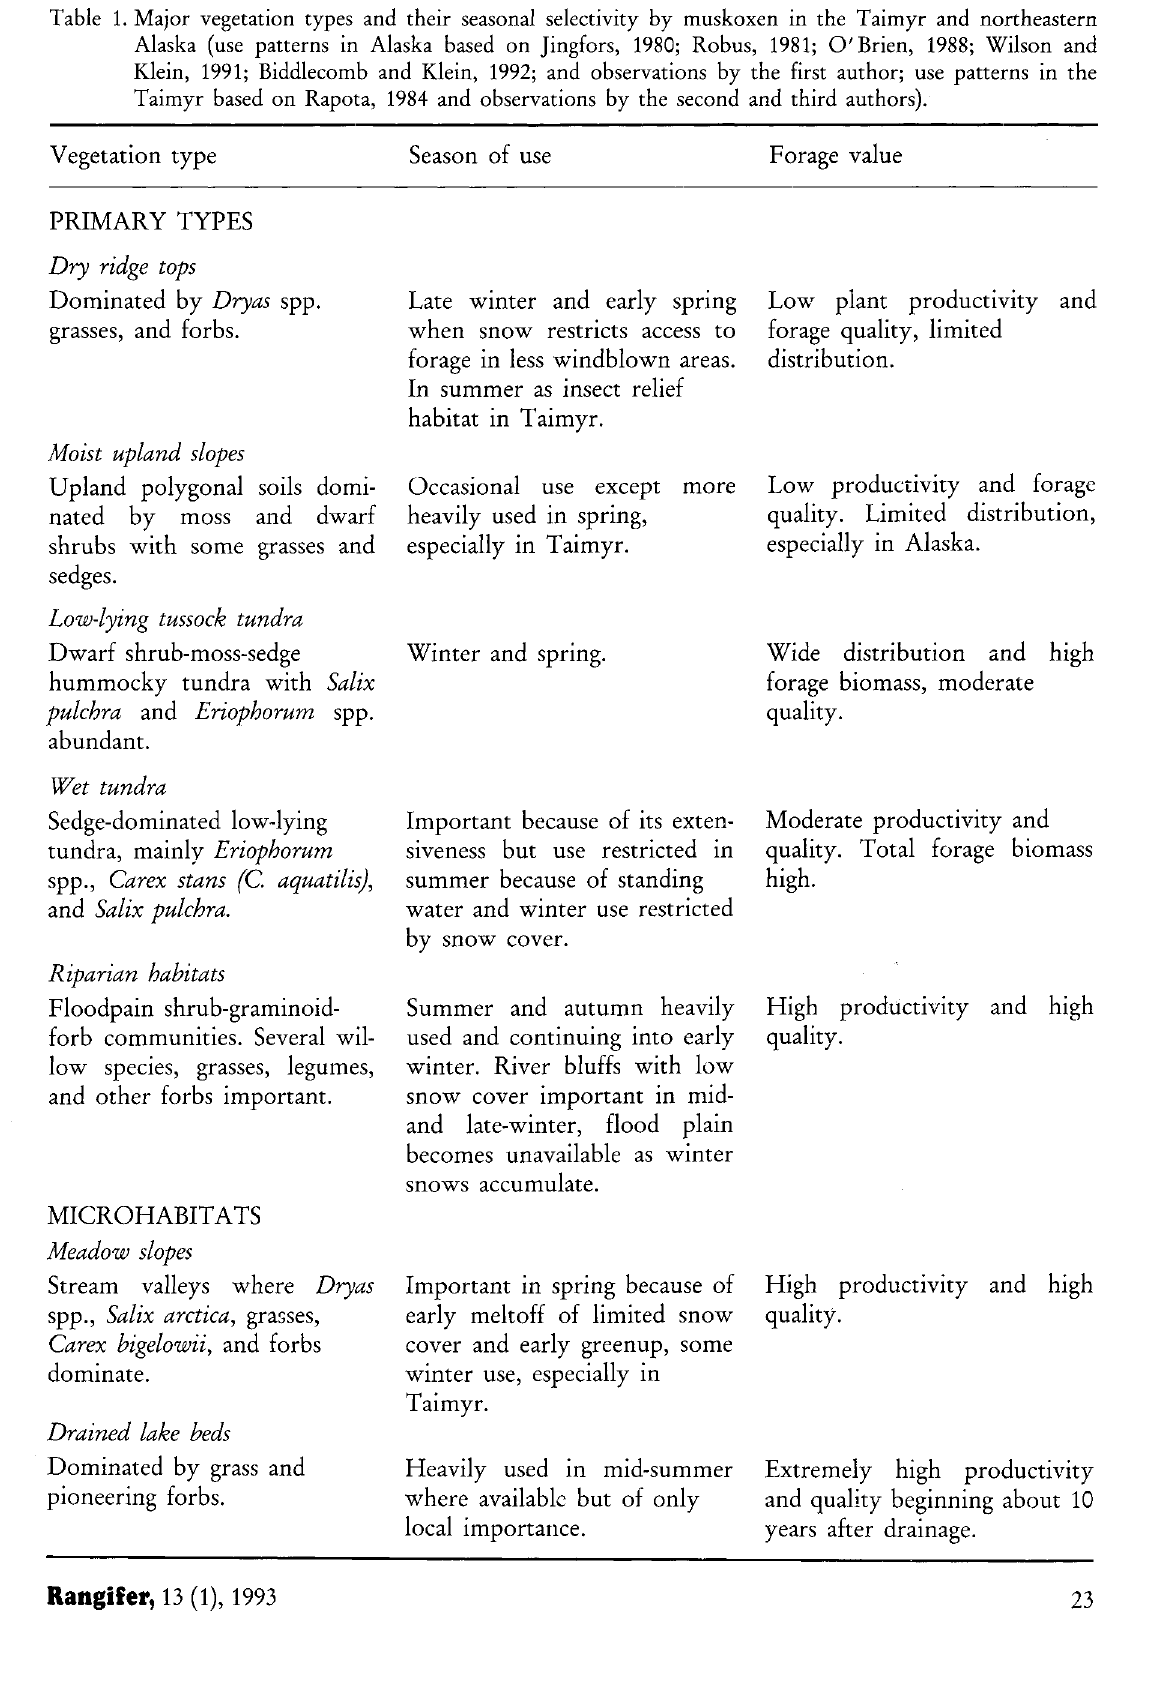
Table 1. Major vegetation types and their seasonal selectivity by muskoxen in the Taimyr and northeastern Alaska (use patterns in Alaska based on Jingfors, 1980; Robus, 1981; O'Brien, 1988; Wilson and Klein, 1991; Biddlecomb and Klein, 1992; and observations by the first author; use patterns in the Taimyr based on Rapota, 1984 and observations by the second and third